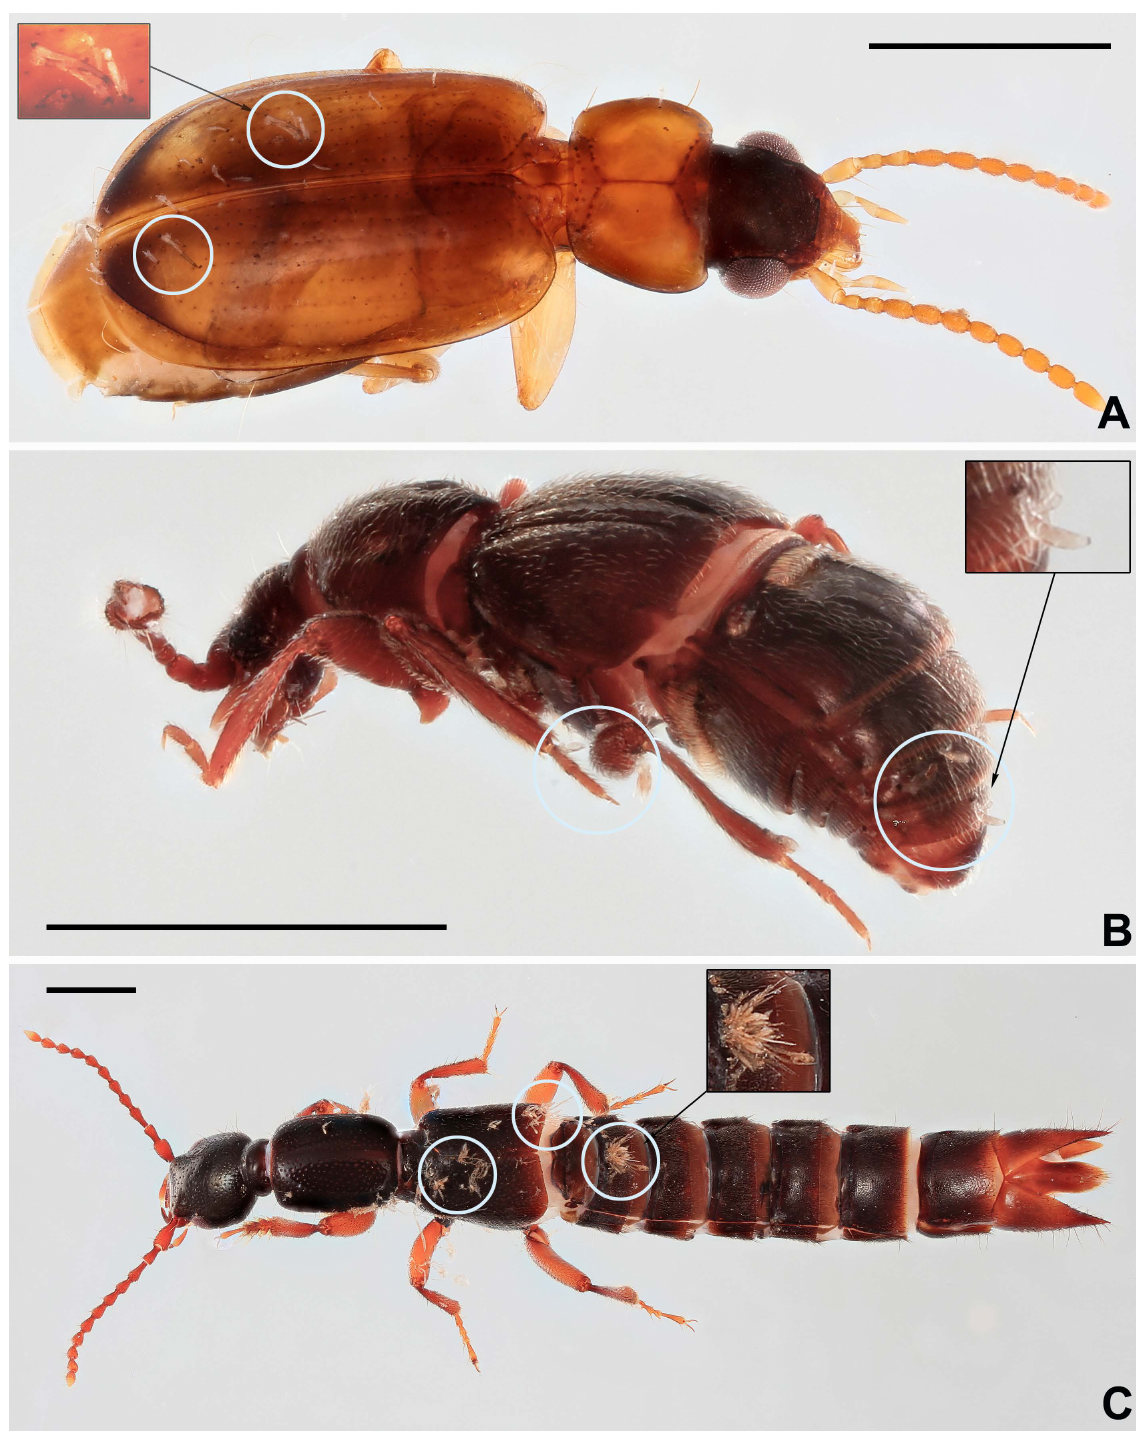
Fig. 105. Habitus of hosts with fungi. Some thalli are zoomed in, and others are encircled. A . Perigona nigriceps with thalli of Laboulbenia manubriolata on dorsal side of the elytra. B . Brachygluta fossulata with a few thalli of Cryptandromyces elegans on the apex of the abdominal segments, on the hind coxa and the tip of the left hind tibia. C . Lathrobium brunnipes with thalli of Rhadinomyces pallidus on various parts of the body. Scale bars: 1 mm. (Photos: Aslak Kappel